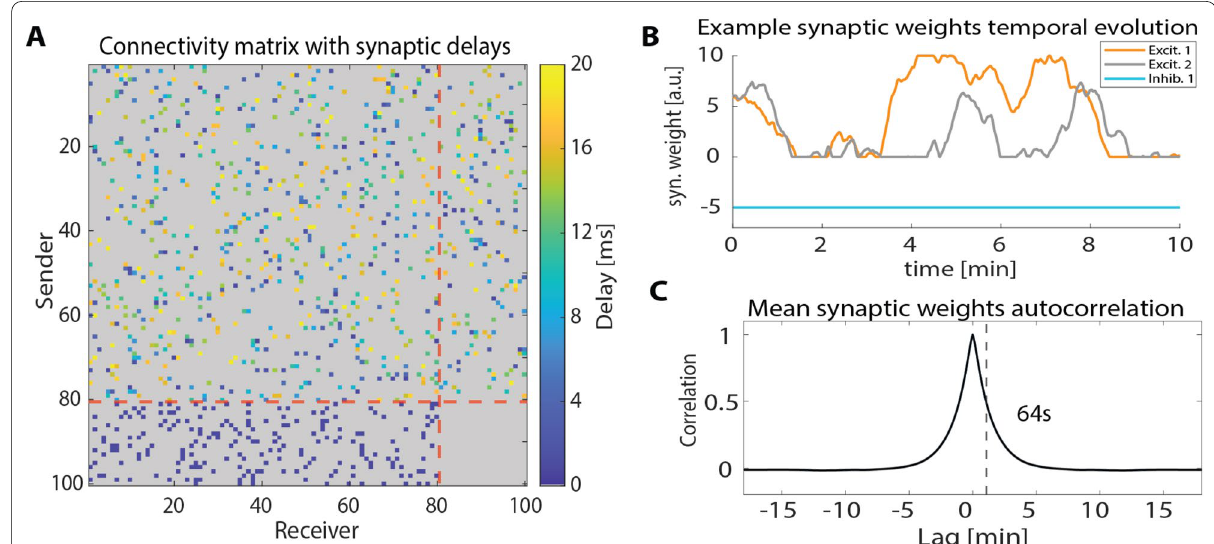
Fig. 2 Ground truth connectivity and synaptic weights evolution. A Example connectivity matrix, all synapses present in the network were colored according to their communication delay. Absent synapses are grey. The red dashed lines separate the excitatory ( N inhibitory ( N 20 neurons) population. B Ground-truth values of three example synaptic weights over time. Excitatory synapses (in orange and = grey) evolved over time due to STDP, inhibitory synapses (in light blue) were constant over time. C Autocorrelation function of synaptic weights, the vertical dashed line indicates the autocorrelation half-life (64